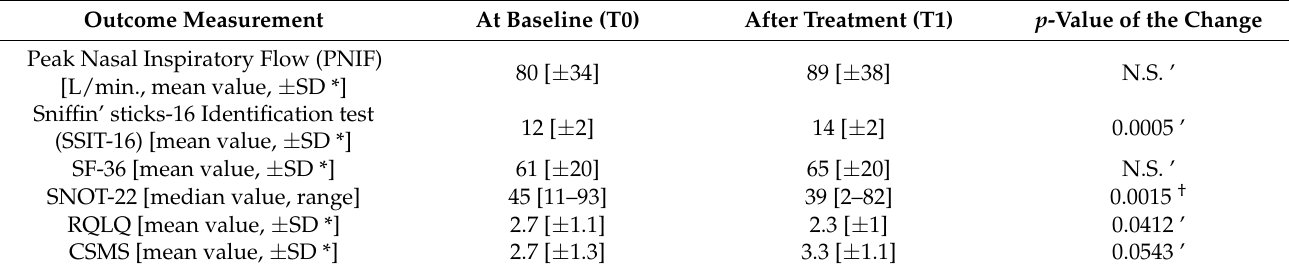
Table 2. Change of outcome measurements after